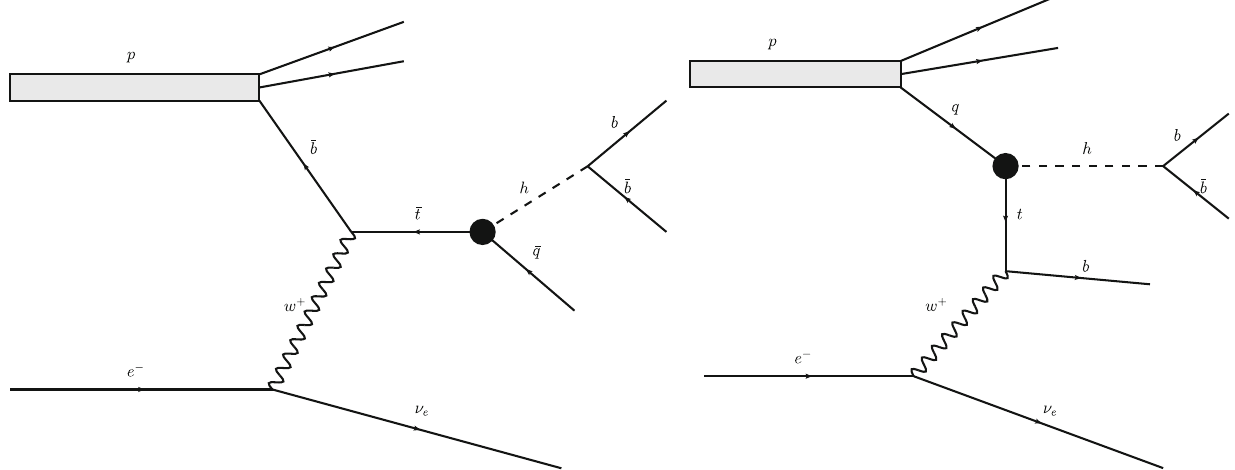
Fig. 1 Illustrated Feynman diagrams for the processes e − p → ν e ¯ t → ν e h ¯ q → ν e b ¯ b ¯ q (signal I) and e − p → ν e hb → ν e b ¯ bb signal II) at the